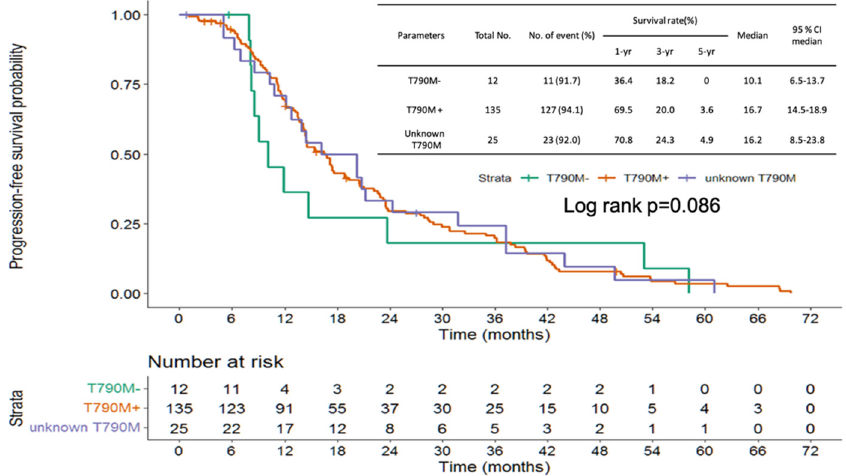
Figure 3. Progression-free survival of frontline EGFR-TKIs based on T790M status.